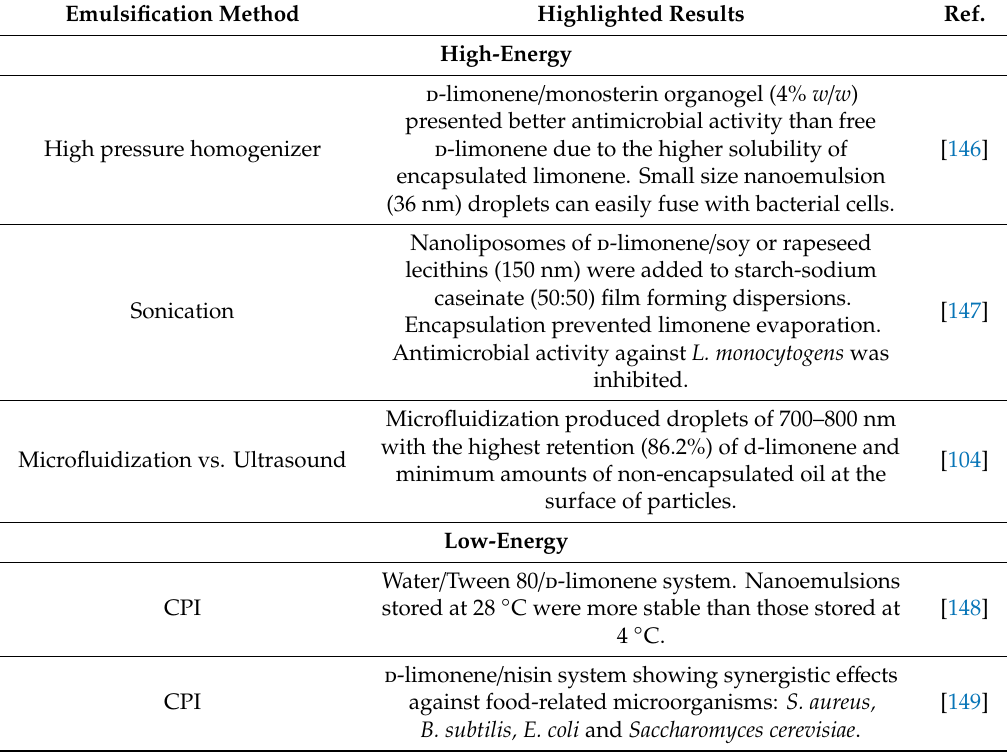
Table 2. Examples of Limonene’s encapsulation using low- and high-energy emulsifying methods. Emulsification Method Highlighted Results Ref.